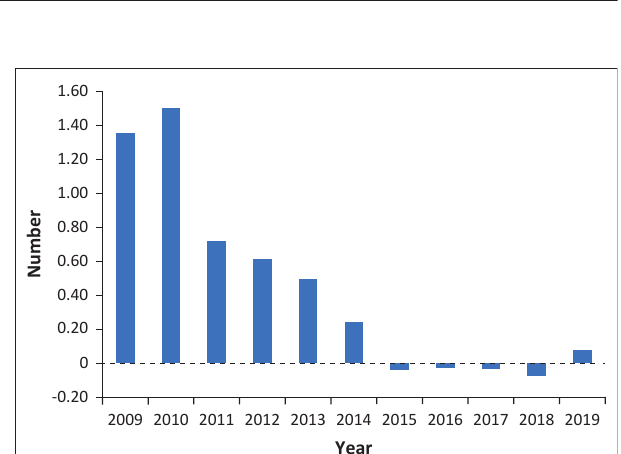
FIGURE 8: The fiscal multiplier over the last